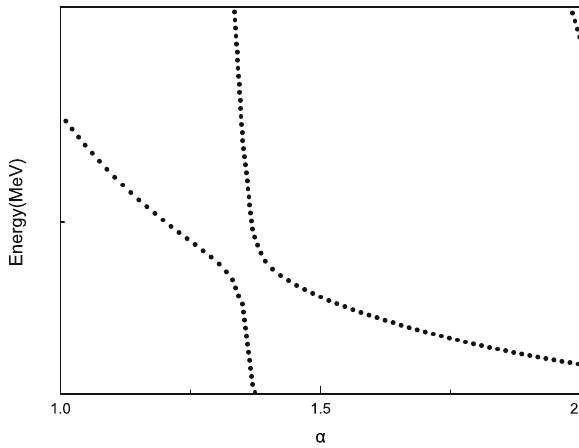
Fig. 1 The shape of the resonance in real-scaling method